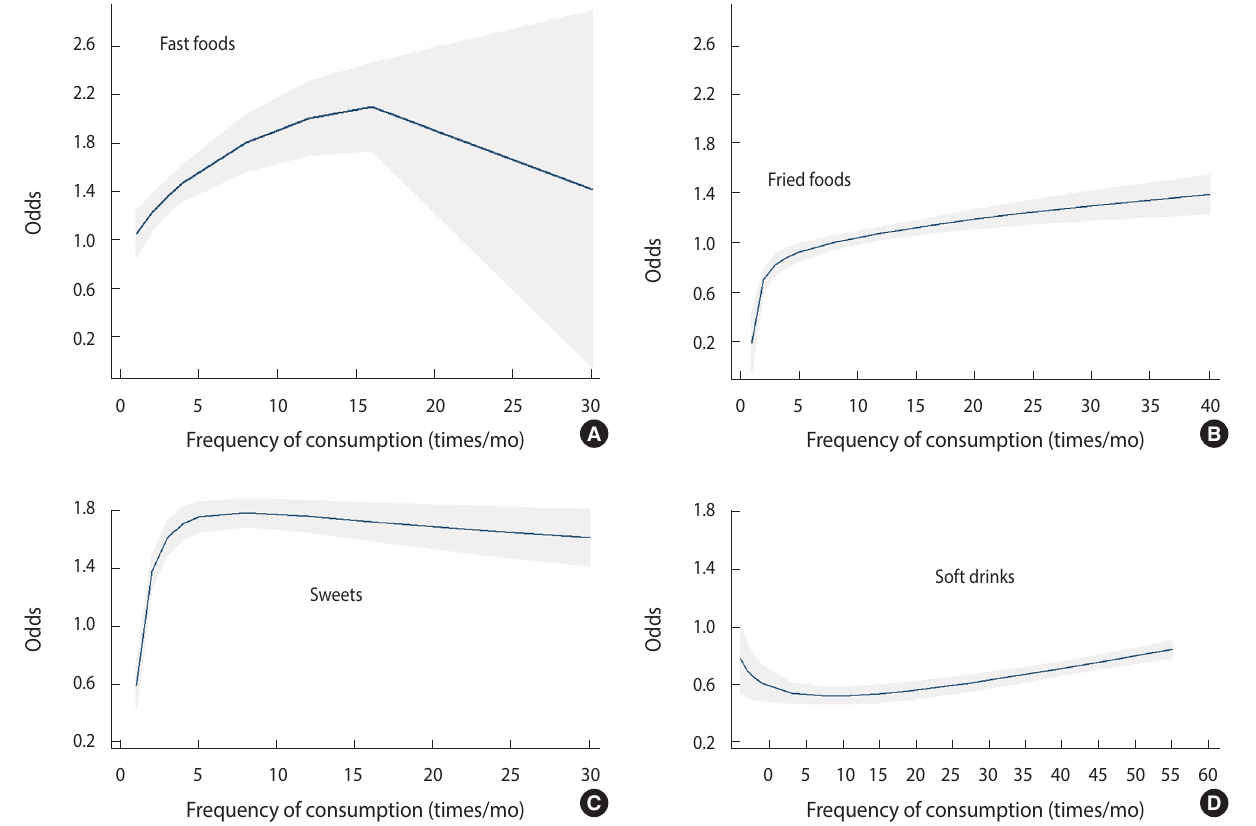
Figure 2. Dose-response relationships of (A) fast food, (B) fried foods, (C) sweets, and (D) soft drinks in terms of the frequency of consump- tion per month with the odds of breast cancer based on fractional polynomials adjusted for demographic variables including age, gender, education level, and body